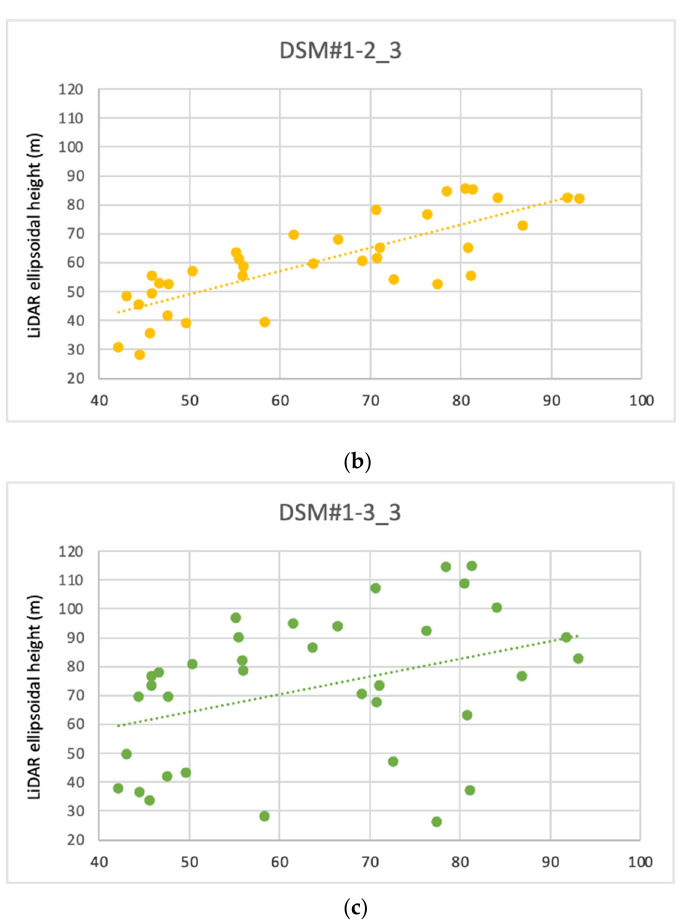
Figure 7. Comparison of ellipsoidal height of the LiDAR dataset and the three best digital surface models: DSM#2–3_1 ( a ), DSM#1–2_3 ( b ) and DSM#1–3_3 ( c ).